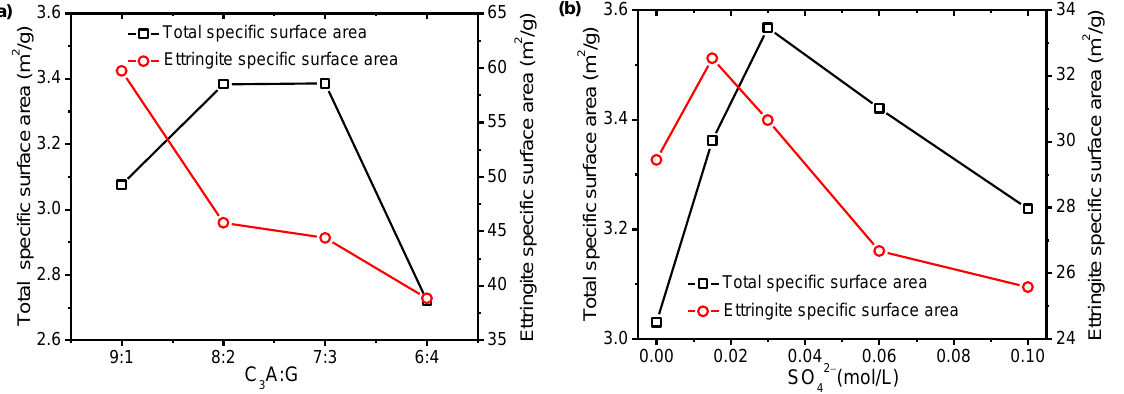
Figure 3. Specific surface area at the first 20 min: ( a ) effect of C 3 A/G; ( b ) effect of the SO 4 2− concentration in simulated solutions.